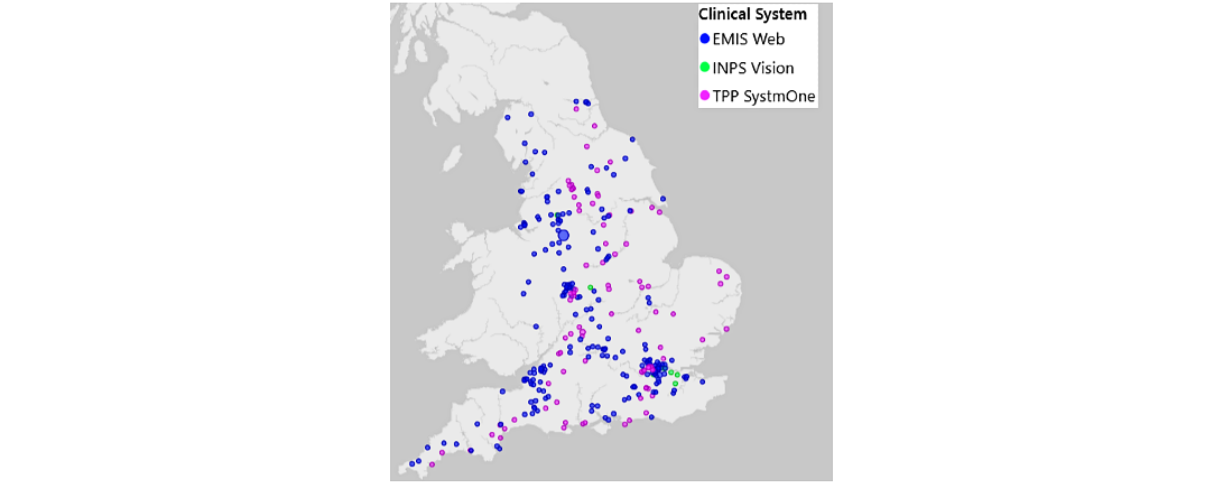
Figure 1. Royal College of General Practitioners Research and Surveillance Centre’s virology sampling sites in England. Distribution by type